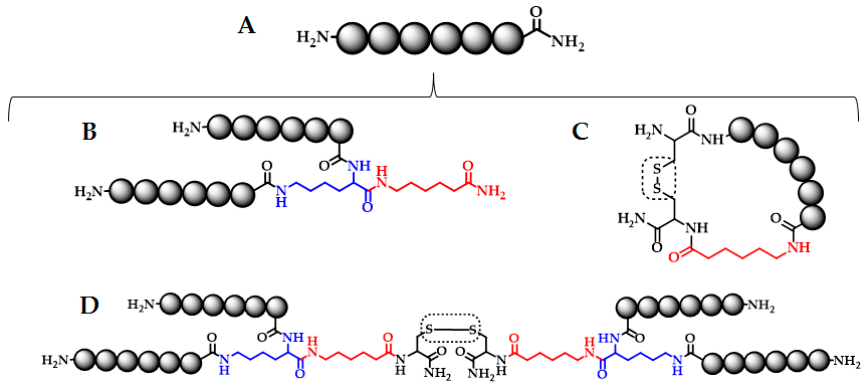
Figure 1. Designed and synthesized peptide families derived from LfcinB. Three families of peptides were obtained, each containing four members: a linear ( A ); a dimeric ( B ); a cyclic ( C ); and a tetrameric ( D ) peptide. As linear peptides, LfcinB (20–25), LfcinB (20–30), and [Ala 19 ]-LfcinB (17–31) were used. The sequence is represented by black spheres; aminohexanoic residues (in red) and lysine residues (in blue) are shown.